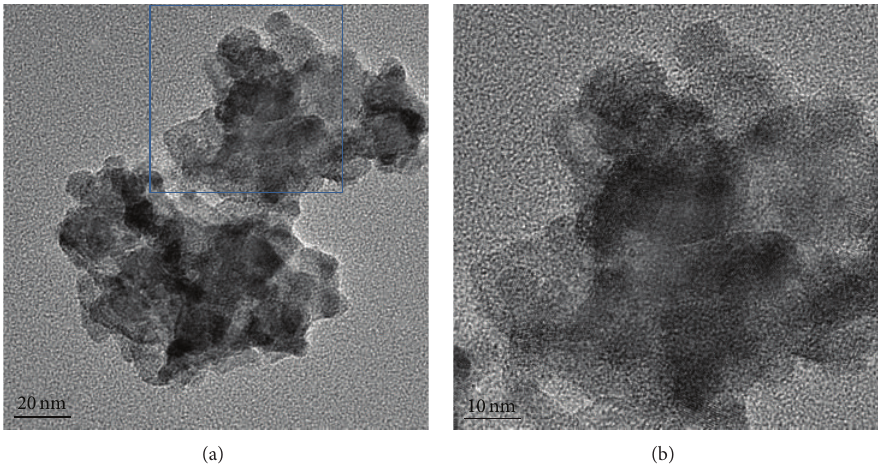
Figure 4: The TEM images of La-doped-CdS/CdSe films: (a) low magnification figure and (b) high magnification figure.